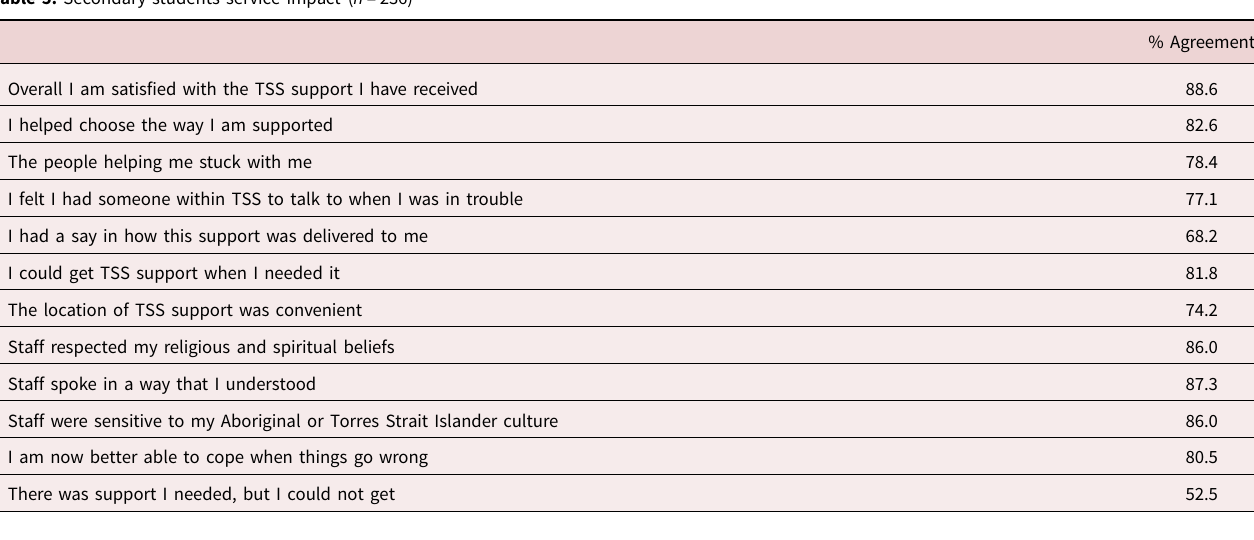
Table 5. Secondary students service impact ( n =236)